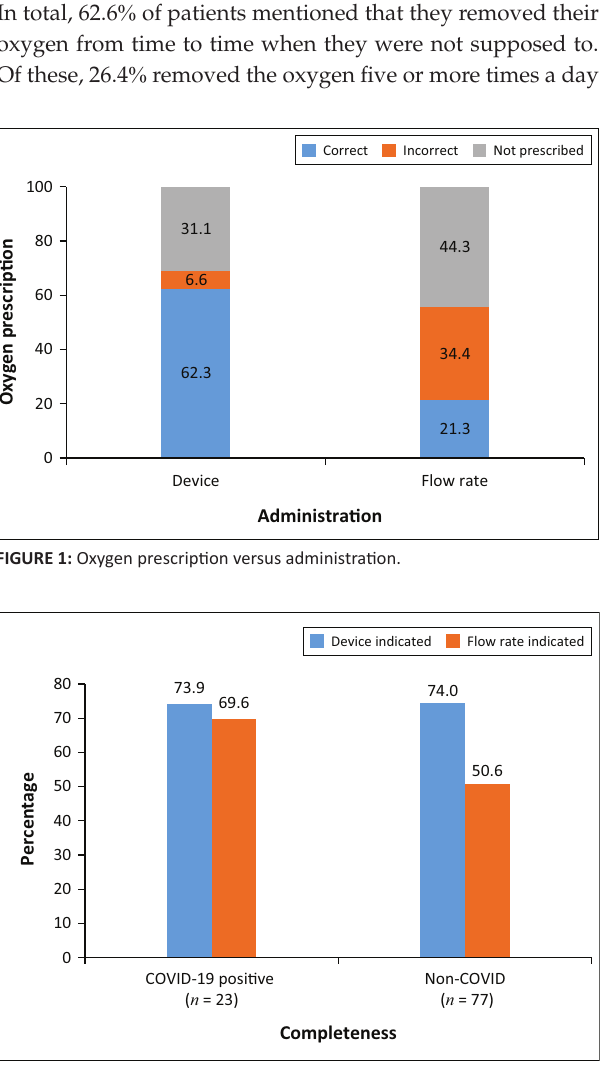
FIGURE 2: Completeness of COVID-19 versus non–COVID-19 prescriptions ( n = 100).